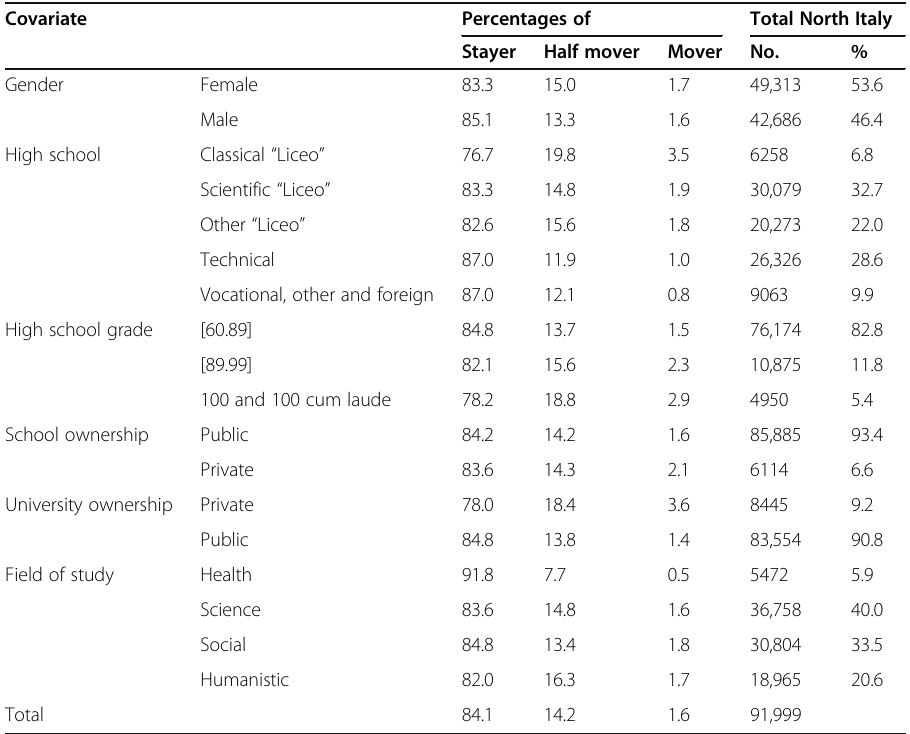
Table 3 Northern first-year students, enroled at an Italian University in 2017, by status , demographic, and school factors Covariate Gender